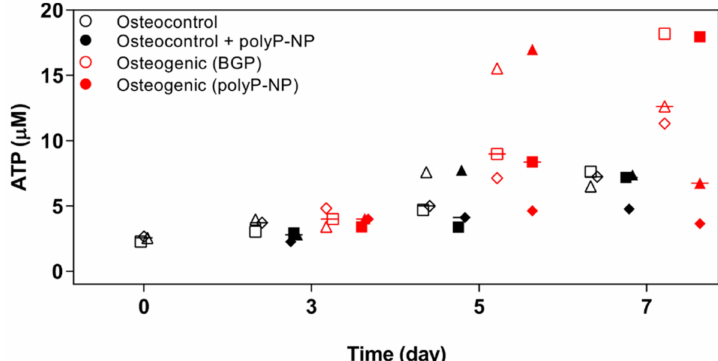
Figure 3. Intracellular ATP content between treatment groups over time. Human BM-MSCs are cultured in osteocontrol media ± polyP-NP, or osteogenic medium containing either BGP or polyP-NP, for 0, 3, 5 or 7 days. ATP content in cells is then determined. Individual data points indicated are the mean of two technical replicates for each independent donor: donor A ( (cid:3) ), donor B ( ∆ ) and donor C ( ♦ ). The mean of the three independent donors within each group is indicated by the horizontal